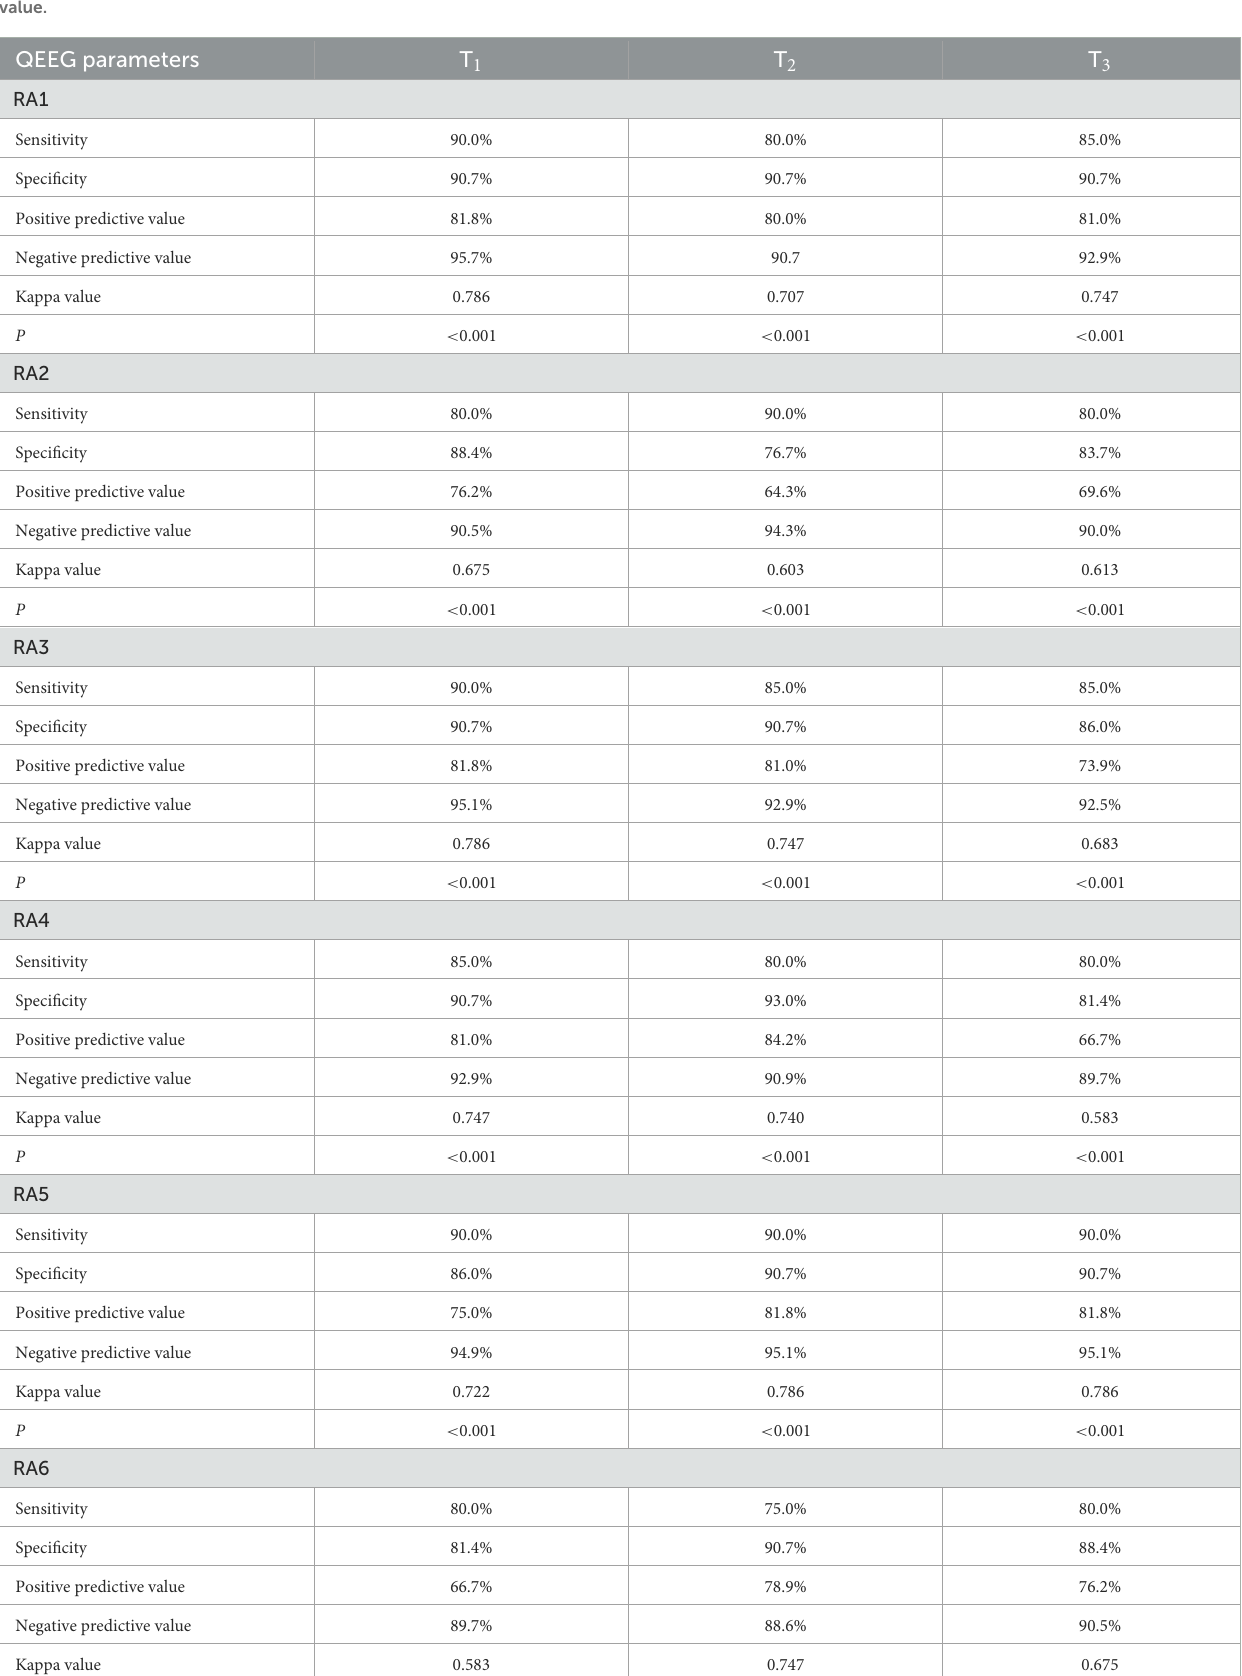
TABLE 4 The accuracy of RA evaluation at different time points of different leads on the surgical side undergoing CEA according to the cut-off point value. QEEG parameters T 1 T